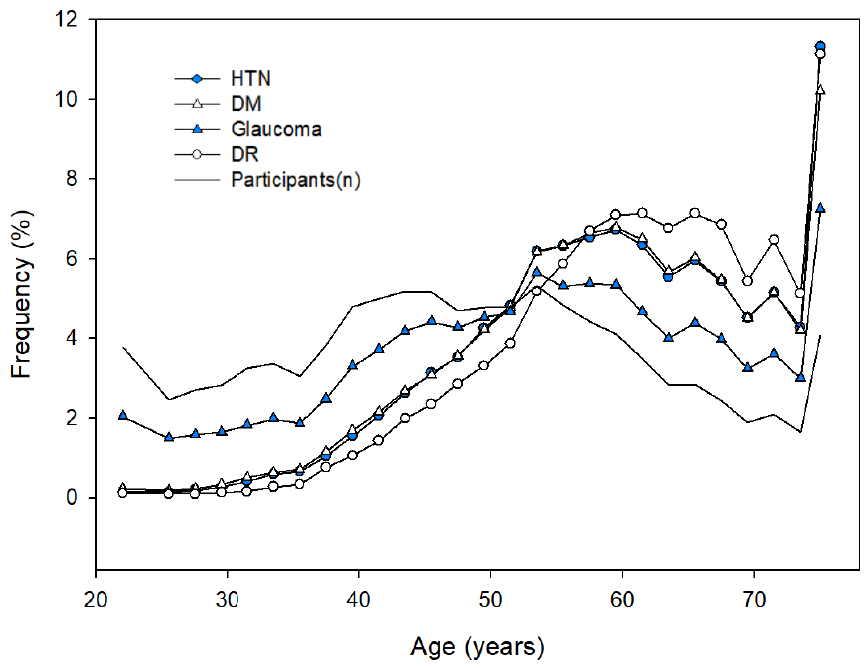
Figure 3. Frequency of diseases with age. DM, diabetes mellitus; DR, diabetic retinopathy; HTN, hypertension.